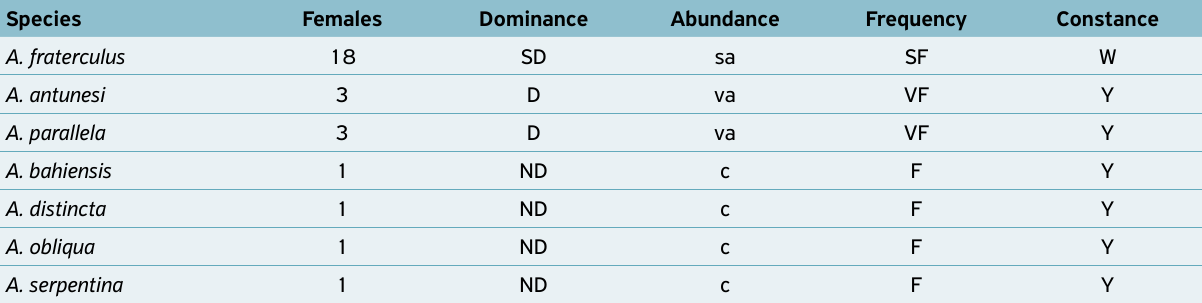
Table 2. Faunistic analysis of captured Anastrepha species in McPhail traps in Uruçuca, Bahia, July/2011 – December 2012. Species Females Dominance